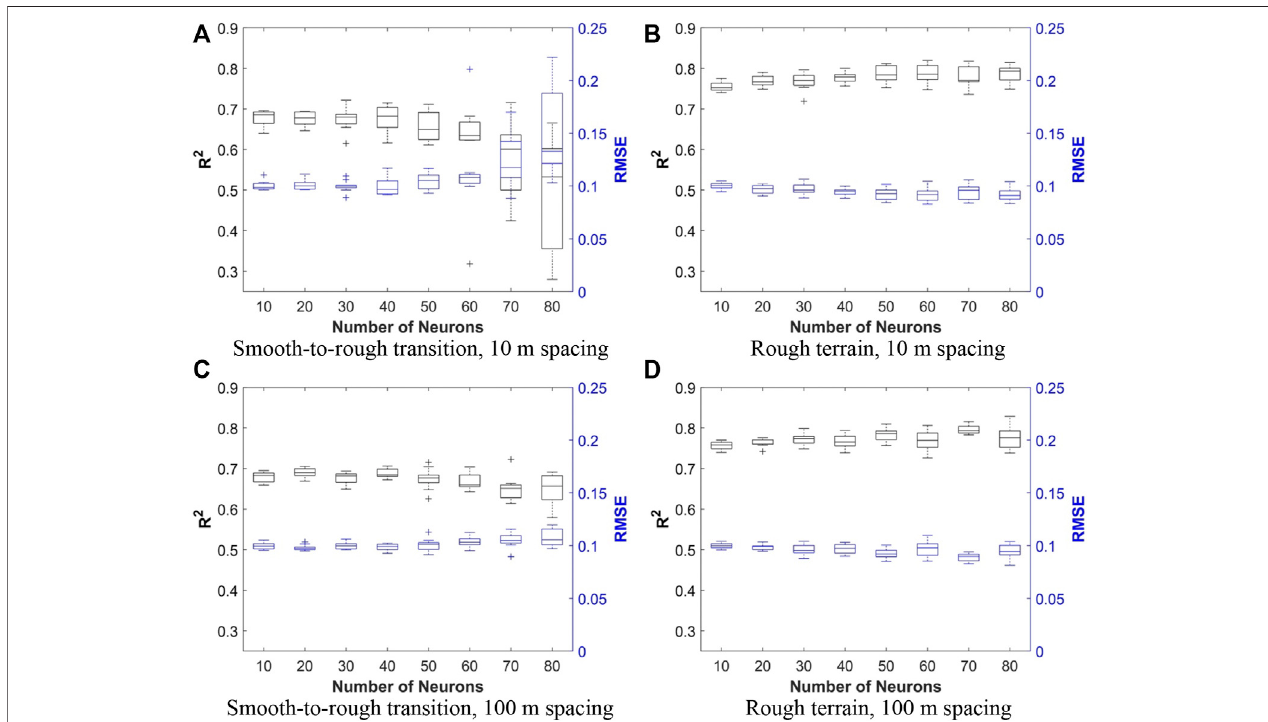
FIGURE 10 | Coef fi cients of determination for varied neuron counts and horizontal spacing between elevation data points in the DEM for the double layer neural network. (A) Smooth-to-rough transition, 10 m spacing. (B) Rough terrain, 10 m spacing. (C) Smooth-to-rough transition, 100 m spacing. (D) Rough terrain, 100 m